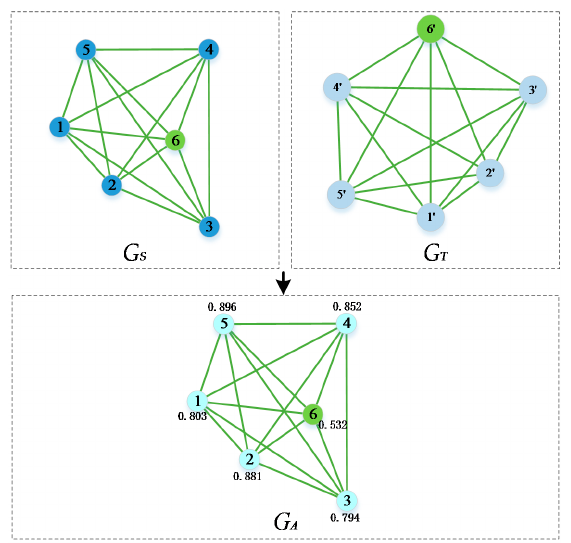
Figure 7. The induced graph of two matched graph.